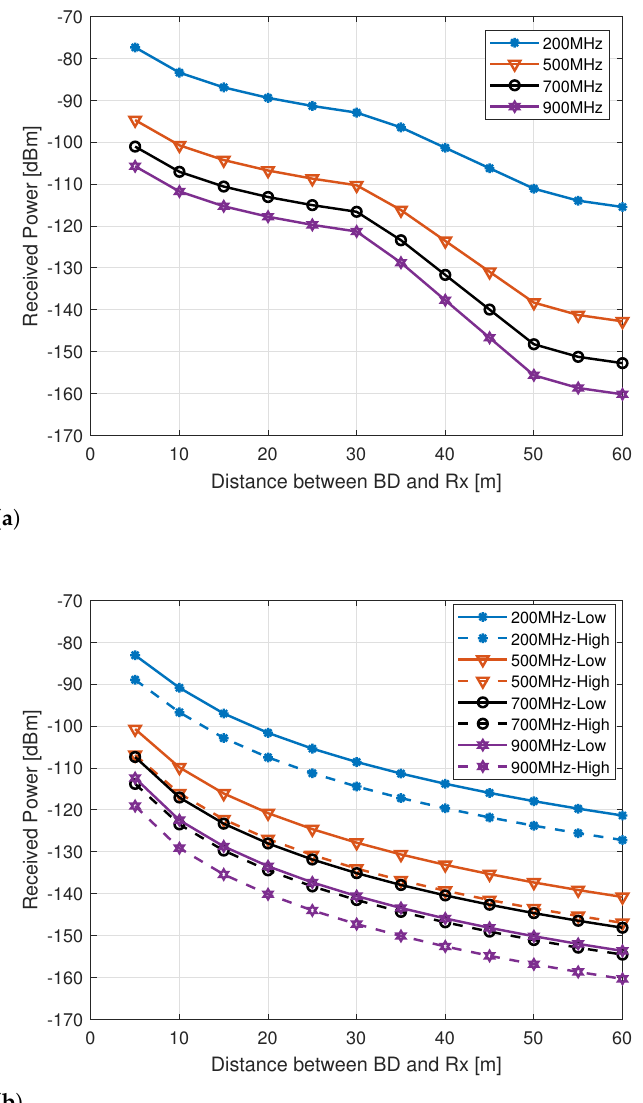
Figure 8. Mean received power with different BD-Rx distance at the receiver for different frequencies, ( a ) Outdoor, and ( b )